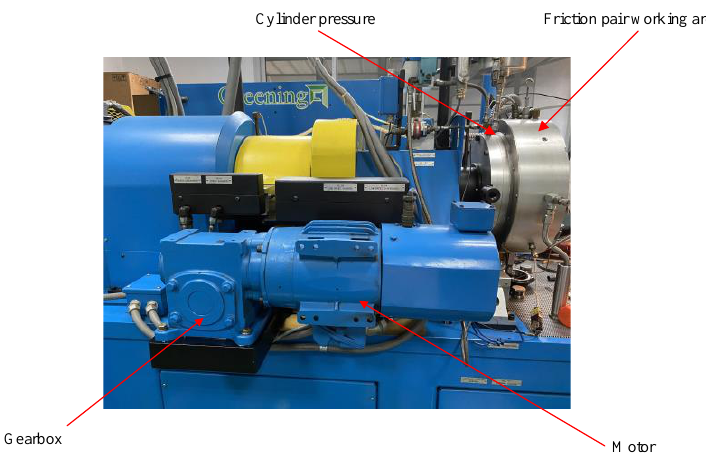
Figure 9. SAE#2 test machine equipment diagram.